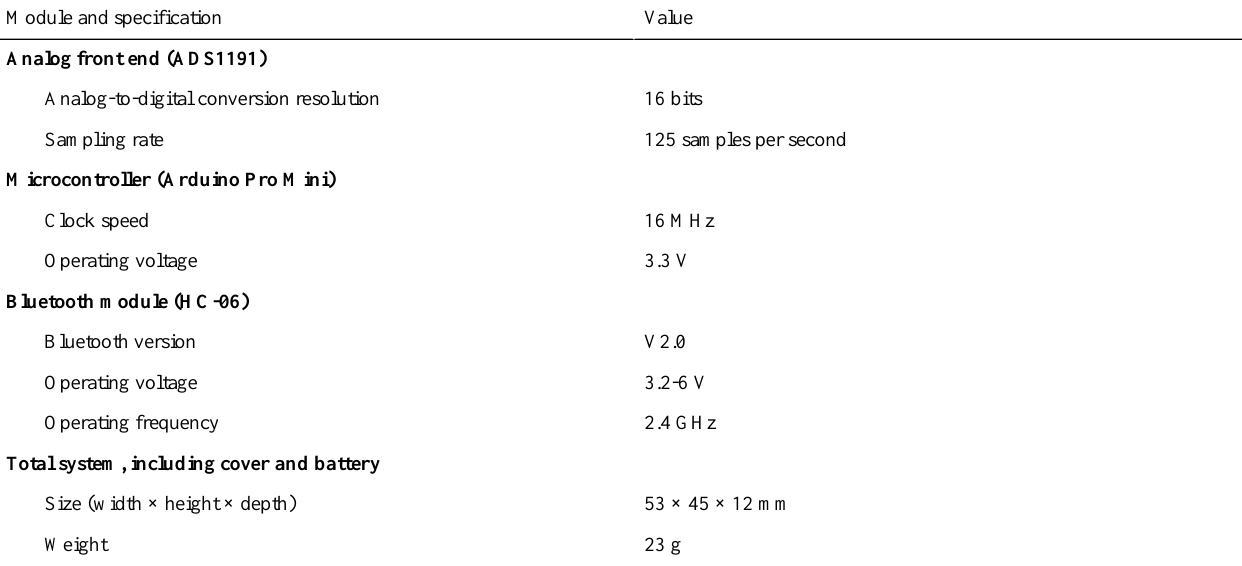
Table 2. Specifications of the developed